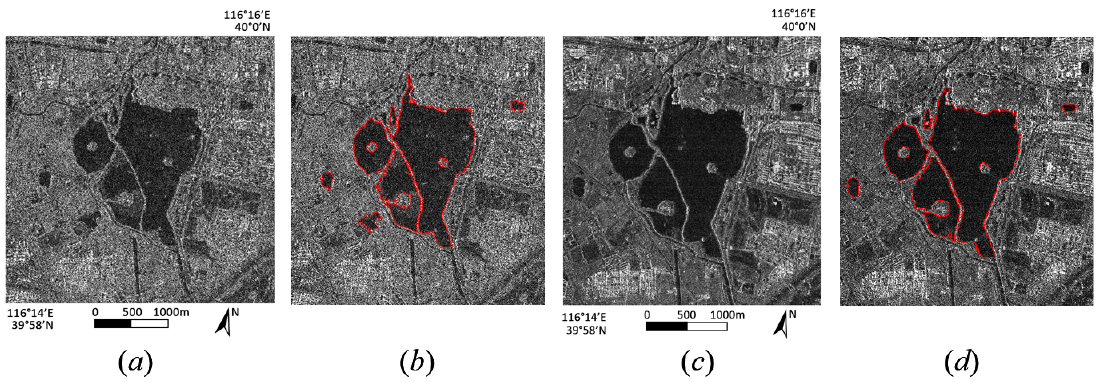
Figure 5. ( a – d ) SAR images and extracted contours: ( a ) Radarsat-2 image, ( c ) TerraSAR-X image; ( b ) and ( d ) are extracted contours of ( a ) and ( c ).